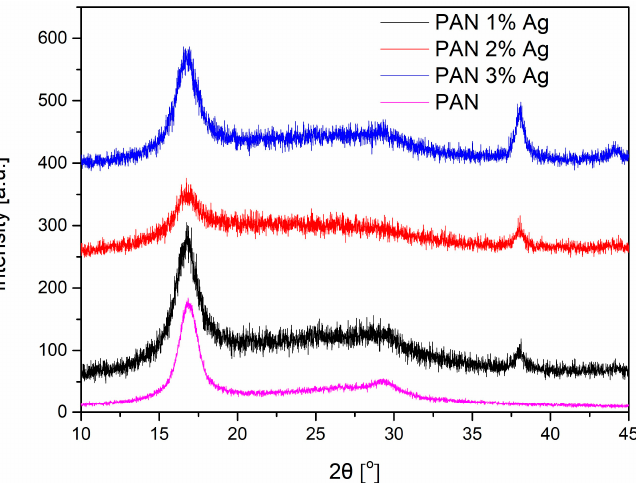
Figure 6. X-ray di ff ractograms of polyacrylonitrile fi bers with di ff erent silver content. Figure 6. X-ray diffractograms of polyacrylonitrile fibers with different silver content. Using the Debye–Scherrer equation (Equation (4)), the average crystallite size of the PAN fibers was calculated on the basis of the half-width of the peak at about 17 ◦ (Table 1). On the other hand, the average size of silver nanoparticle crystallites was determined di ff raction curve was analyzed by creating the theoretical function with the best fi t to the on the basis of the half-width of the peak occurring at about 38 ◦ (characteristic for the experimental curve. The curve fi tt ing was performed using the Rosenbrock method. This crystallographic plane (111) of silver). The presence of silver nanoparticles increased the method enabled a good fi t in WAXSFIT [31]. degree of crystallinity from 0.33 to 0.47, regardless of the amount of silver addition. The size of silver crystallites increased with the increase in silver content in the fiber and ranged from 7 to 11 nm.